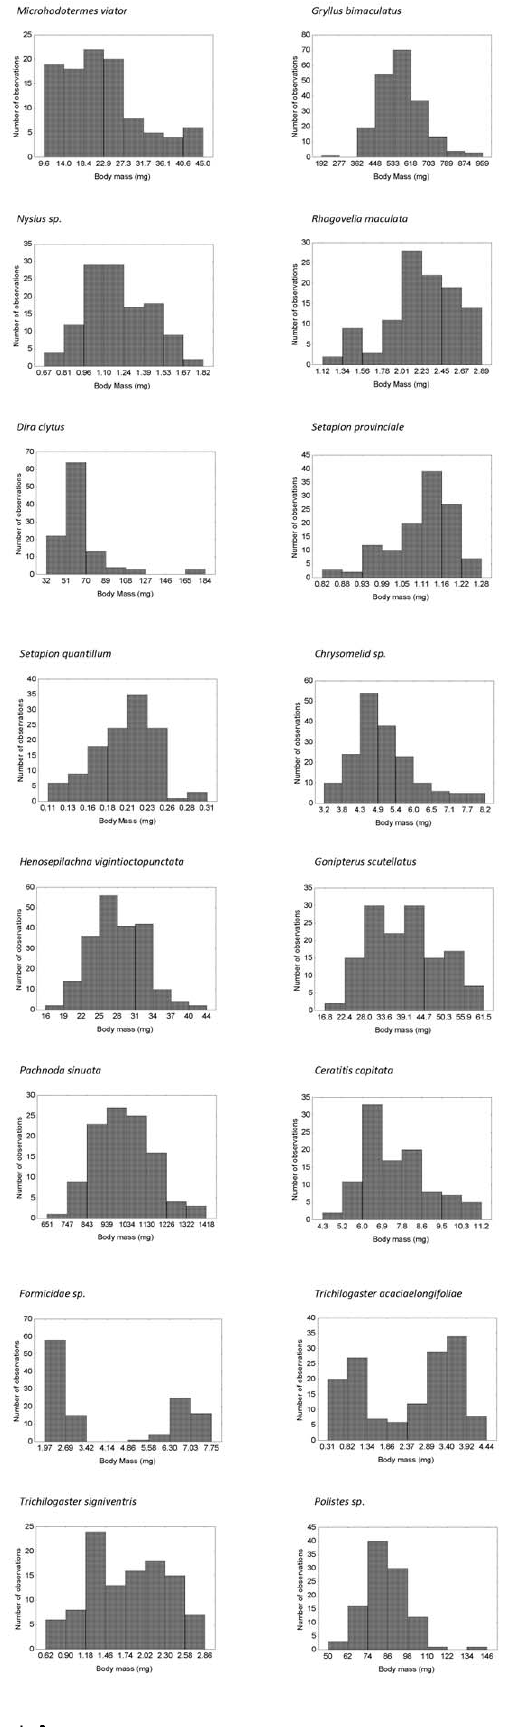
Figure 1. Body mass frequency distributions of the 16 species sampled for this study.